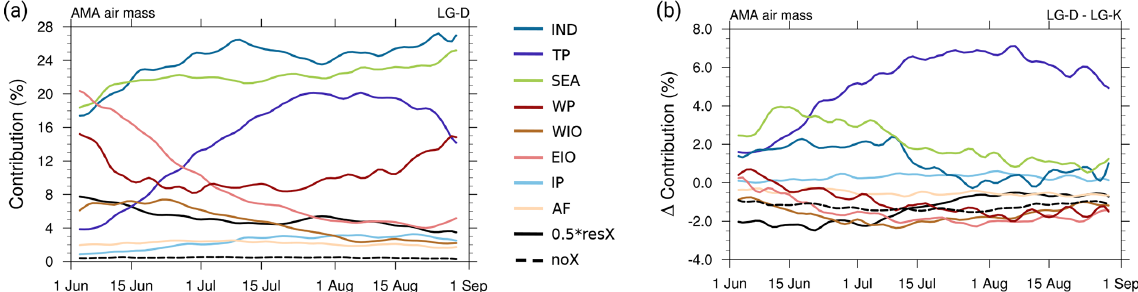
Figure 15. (a) PBL source contribution evolution in the LG-D data. resX data have been scaled by 0.5. All contributions have been temporally smoothed using 5d running means (weights of each day. Panel (b) is as in (a) but for the difference of the source contributions for LG-D minus LG-K. As in the LG-K data the year 2008 is missing (see Sect. 2.3), it was also removed in the LG-D data for this analysis. Colour coding as in (a) .